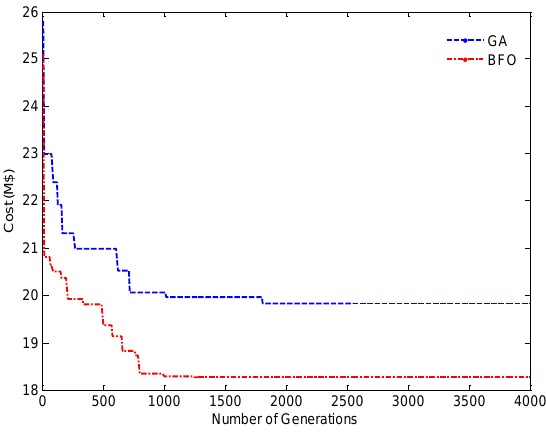
Figure 7. Convergence curve for BFOA and